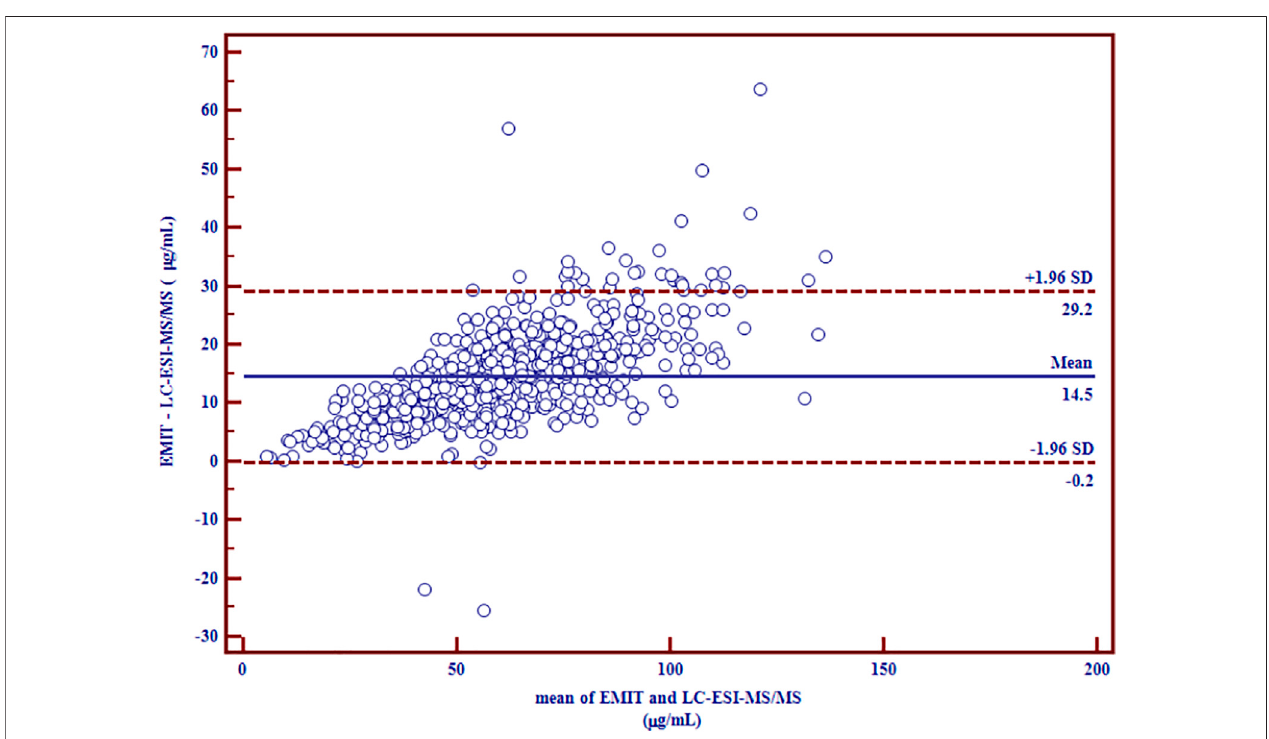
FIGURE 2 | Differences between mean plasma VPA concentrations (µg/ml) measured by LC-ESI-MS/MS and EMIT assay expressed as absolute bias ( n (cid:2) 774).